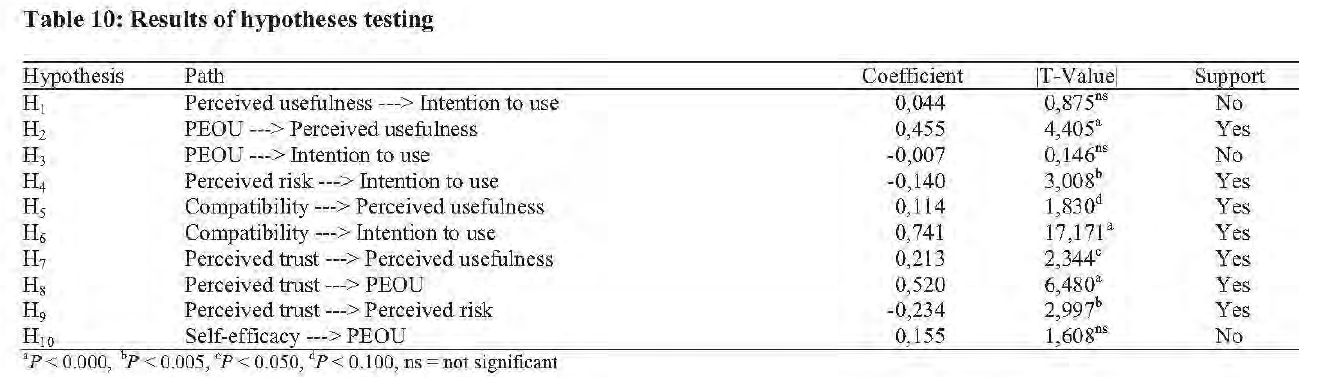
Table 10: Results of hypotheses testing Hypothesis Path Perceived usefulness ---> Intention to use PEOU ---> Perceived usefulness PEOU --->Intention to use Perceived risk---> Intention to use Compatibility---> Perceived